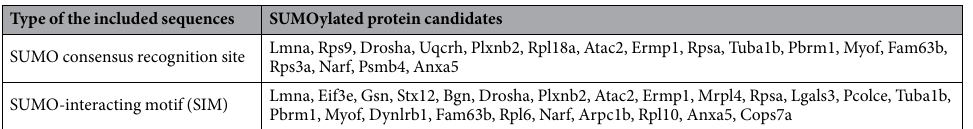
Table 2. Classification of the identified SUMOylated protein candidates according to the presence of SUMO consensus recognition site or SUMO-interacting motif (SIM).